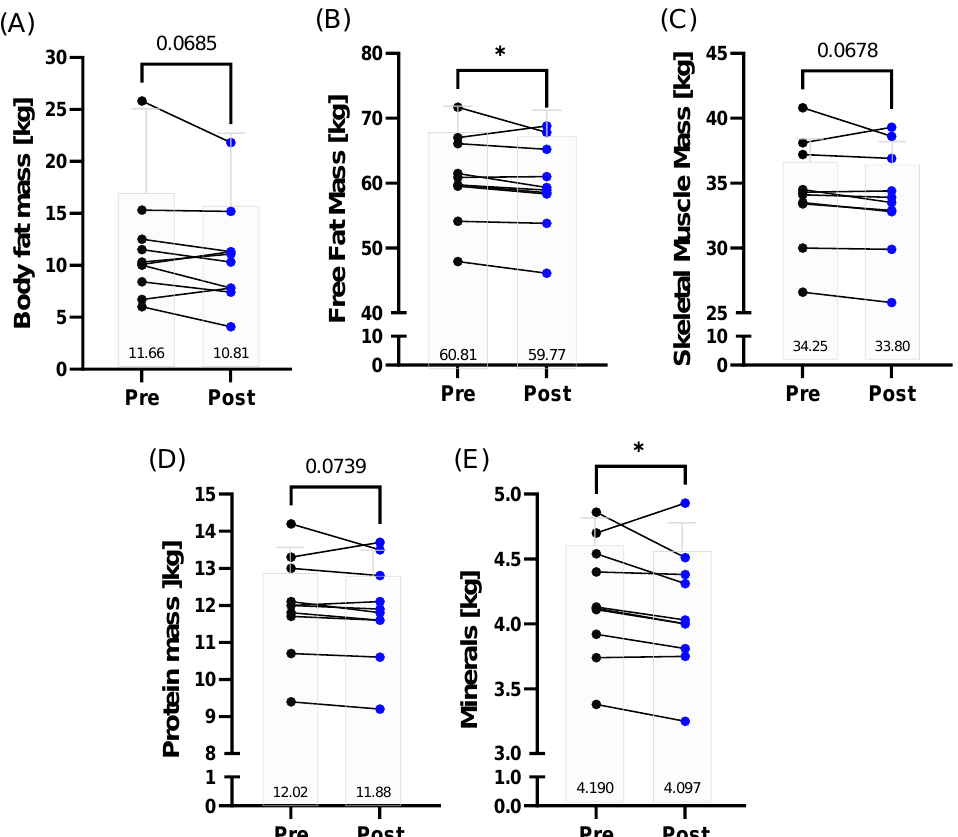
Figure 1. Body composition variables related to tissue distribution and micronutrients of the 160.9/230 km finishers before (pre) and after (post) the race (full dataset obtained for n = 9). The decrease in ( A ) body fat mass, ( C ) skeletal muscle mass, and ( D ) protein mass was on the verge of statistical significance. ( B ) Free fat mass and ( E ) mineral content were significantly decreased post-race. Individual changes as well as mean number values are presented. * p ≤ 0.05.